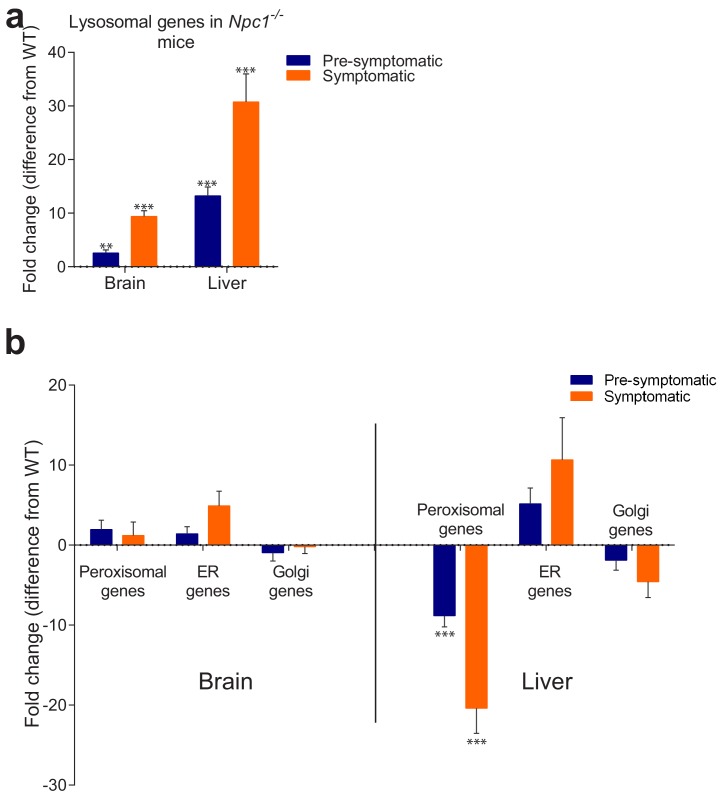
Disease progression changes in the expression of mitochondria-related genes in brain and liver of NPC1 KO mice.Of the 1049 mitochondria-related genes analyzed, we determined how many of them were in the differentially-expressed gene (DEG) list of NPC1 KO mice brain and liver. The dot plots show all mitochondria-related genes, with the ones significantly changed between NPC1 KO and WT denoted in yellow. (a–b) Volcano plot depicting the fold change and significance p-value of mitochondria-related genes in pre-symptomatic (panel a) and symptomatic (panel b) NPC1 KO brain versus WT. Note the increase in differentially-regulated mitochondrial genes (yellow dots) with the onset of the symptoms. (c) Sharp increase (~4 fold) in the proportion of mitochondrial genes that are differentially-regulated in the asymptomatic and symptomatic NPC1 KO brain compared to WT. Fisher's exact test p-value ***p<0.001. (d–e) Volcano plot depicting the fold change and significance p-value of mitochondria-related genes in pre-symptomatic (panel d) and symptomatic (panel e) NPC1 KO liver versus WT. Note the increase in differentially-regulated mitochondrial genes (yellow dots), mostly in the down-regulated side, with the onset of the symptoms. (f) Sharp increase (~5 fold) in the proportion of mitochondrial genes that are differentially-regulated in the asymptomatic and symptomatic NPC1 KO liver compared to WT. Fisher's exact test p-value ***p<0.001, n = 6 (NPC1 KO and WT liver), n = 5 (NPC1 WT brain) and n = 11 (NPC1 KO brain).